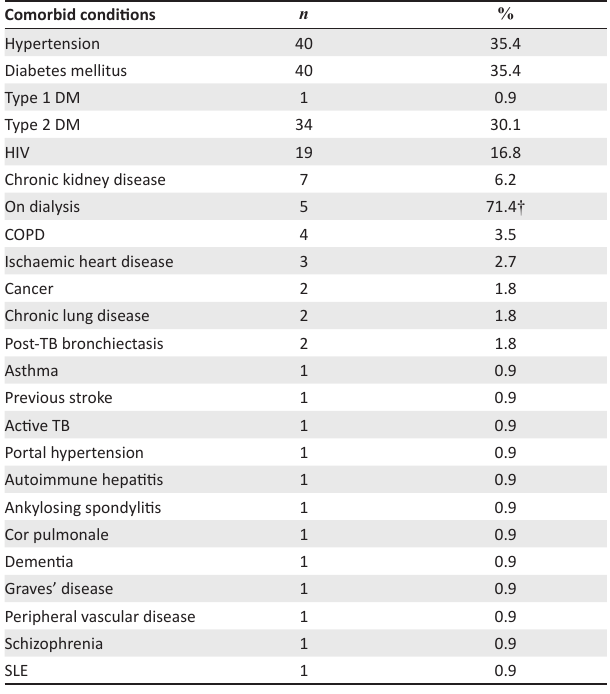
TABLE 1b: Comorbid conditions ( n =